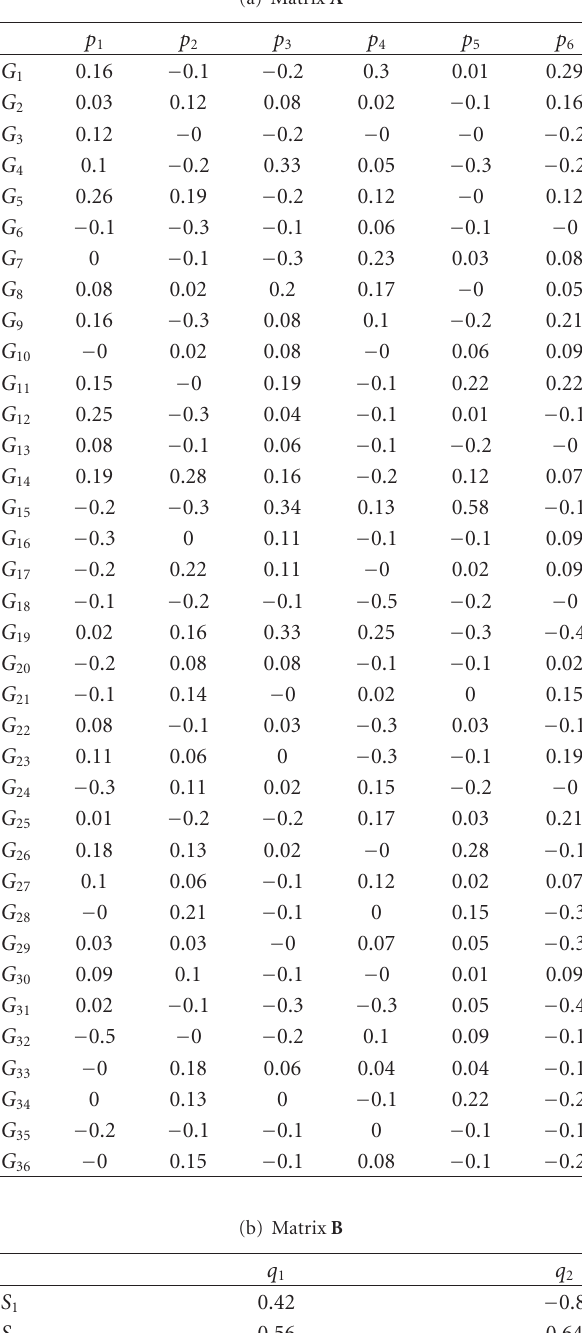
Table 1: 6 × 2 × 3 solution for AMMI model with multiples